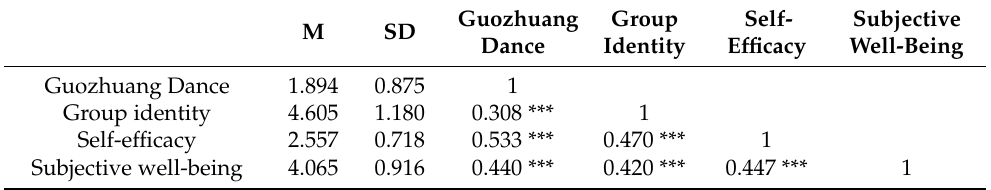
Table 4. Descriptive statistics and correlations among the main variables.